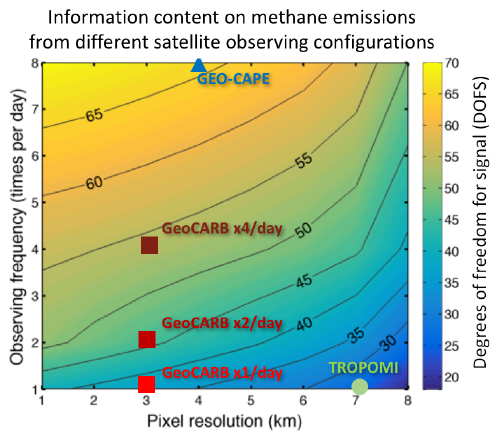
Figure 5. Information content of different satellite observing con- figurations for constraining the distribution of methane emissions in the Southeast US. The figure shows the degrees of freedom for signal (DOFS) for a 1-week observation period aiming to constrain 216 emission elements in the Gaussian mixture model character- izing the distribution of emissions at up to 25km resolution. The configurations are defined by their observing frequency and pixel resolution. The DOFS for the TROPOMI, GeoCARB (one, two, and four measurements per day), and GEO-CAPE observations are in-